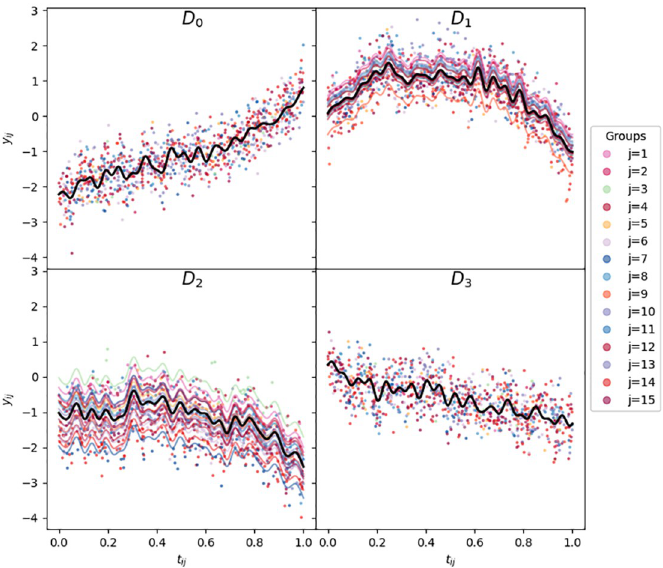
Fig 1. Simulated datasets, D ; ... ; D . Each dot represents a datapoint, with the model covariates x = g ( t ) a 0 3 deterministic and multi-valued non-linear function of t . In addition, the line b T x is shown for all values of t 2 [0, 1] for each dataset. For D , the lines b T x + h j are also included, for j = 1, ... , J = 15. Similarly, for D 2 also included, where z is also a deterministic multi-valued function of t